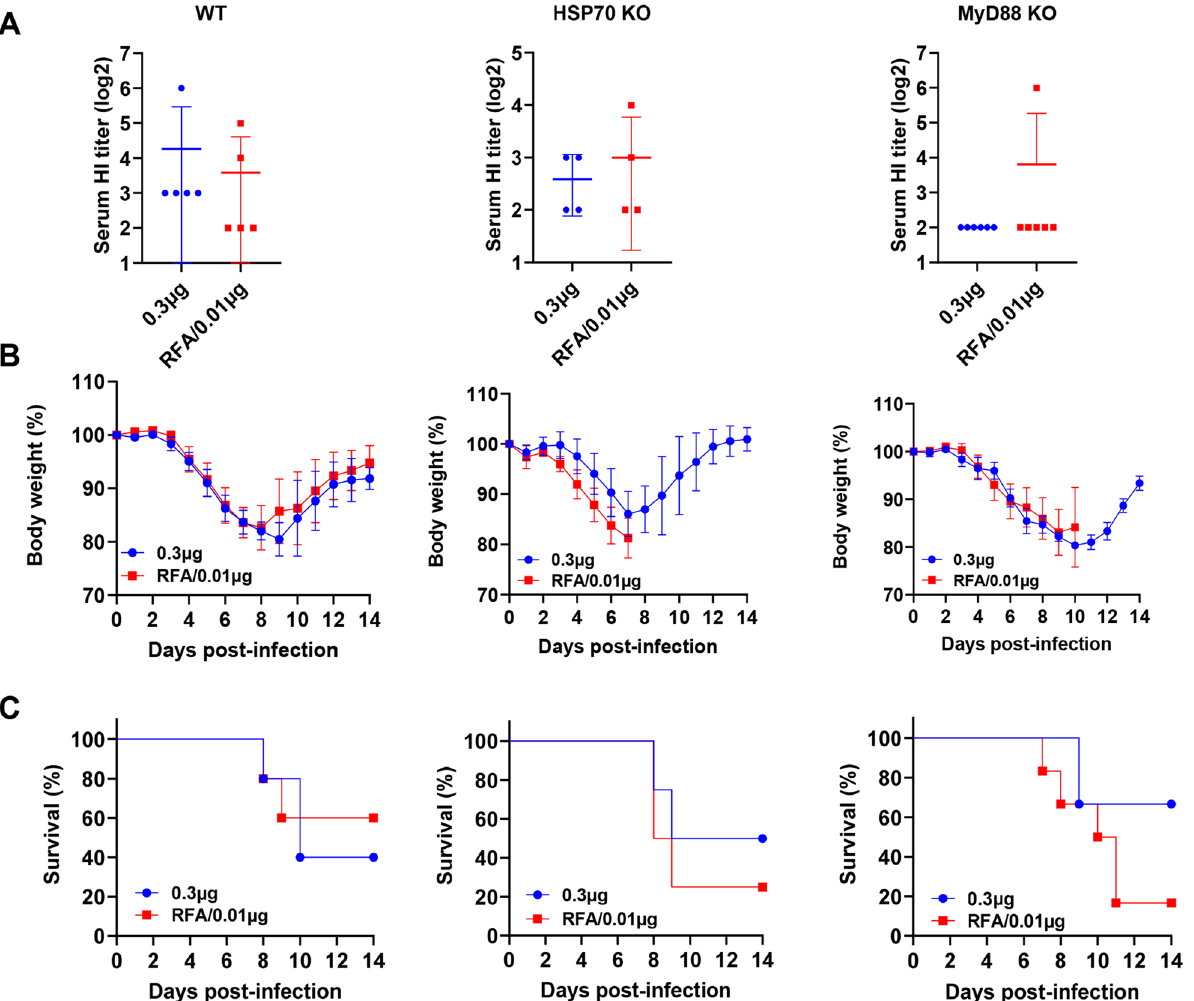
Figure 5. Crucial roles of HSP70 and MyD88 in dose-sparing effects of RFA. WT (C57BL/6), HSP70 KO, and MyD88 KO mice were intradermally injected with 0.3 µg H3N2 vaccine or subjected to RF treatment followed by ID injection of H3N2 vaccine at 0.01 µg dose. Serum HI titers were measured three weeks later ( A ). Mice were challenged with 50 × LD50 of H3N2 viruses four weeks after immunization. Body weight change ( B ) and survival ( C ) were monitored daily for 14 days. n = 5 for WT, n = 4 for HSP70 KO, n = 6 for MyD88 KO. Two-tailed student’s t-test was used to compare differences in ( A ). Two-way ANOVA with Dunnett’s multiple comparison test was used to compare differences between groups at different time points in ( B ). Log-rank test with Bonferroni correction was used to compare differences of survival between groups in ( C ). No significant difference was found in all comparisons in A-C.